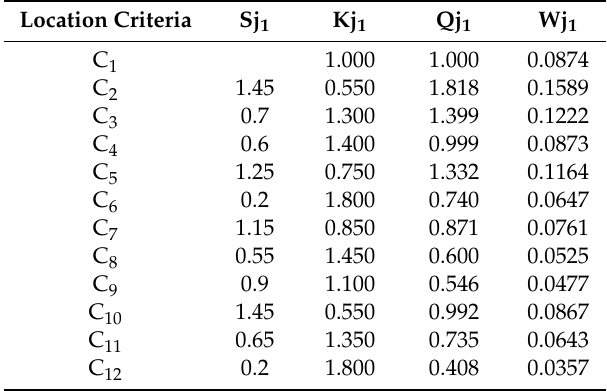
Table 11. Response of the first member of the educators / executives (EE) panel.